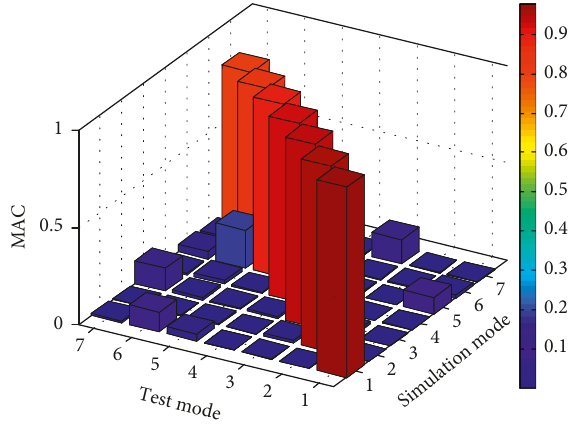
Figure 13: Updated MAC